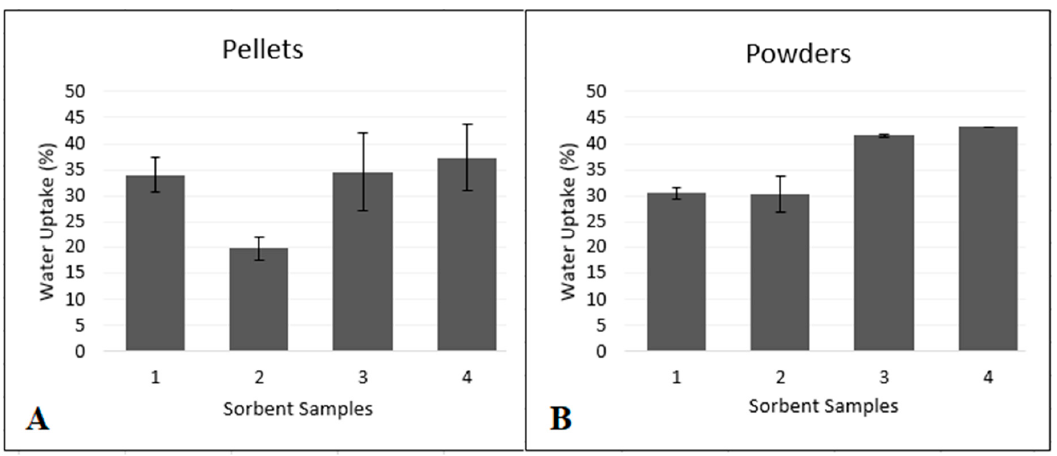
Figure 6. ( A ) Water absorption properties of compressed (pelletized) Ag-Si/Al 2 O 3 sorbents. ( B ) Water absorption properties of powdered Ag-Si/Al 2 O 3 sorbents.